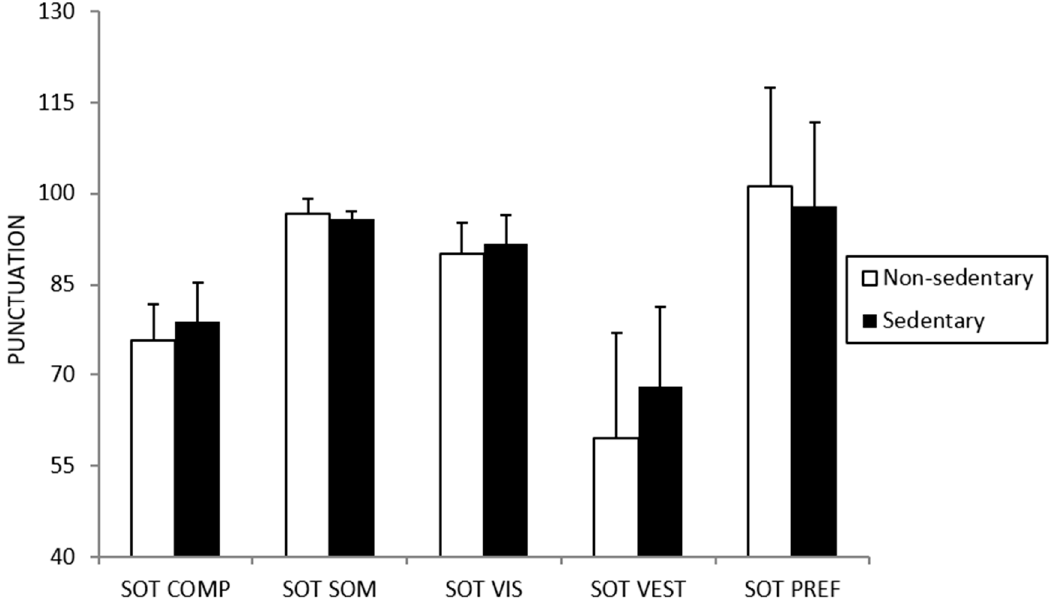
Figure 1. Differences in postural control between sedentary and non-sedentary participants. There were differences between sedentary and non-sedentary participants when the median of the total fat mass percentage was considered (see Table 2). Non-sedentary participants with a high total fat mass percentage presented better results in the SOT-SOM and worse results in the SOT-CES compared to their sedentary counterparts (i.e., 96.9 ± 1.8